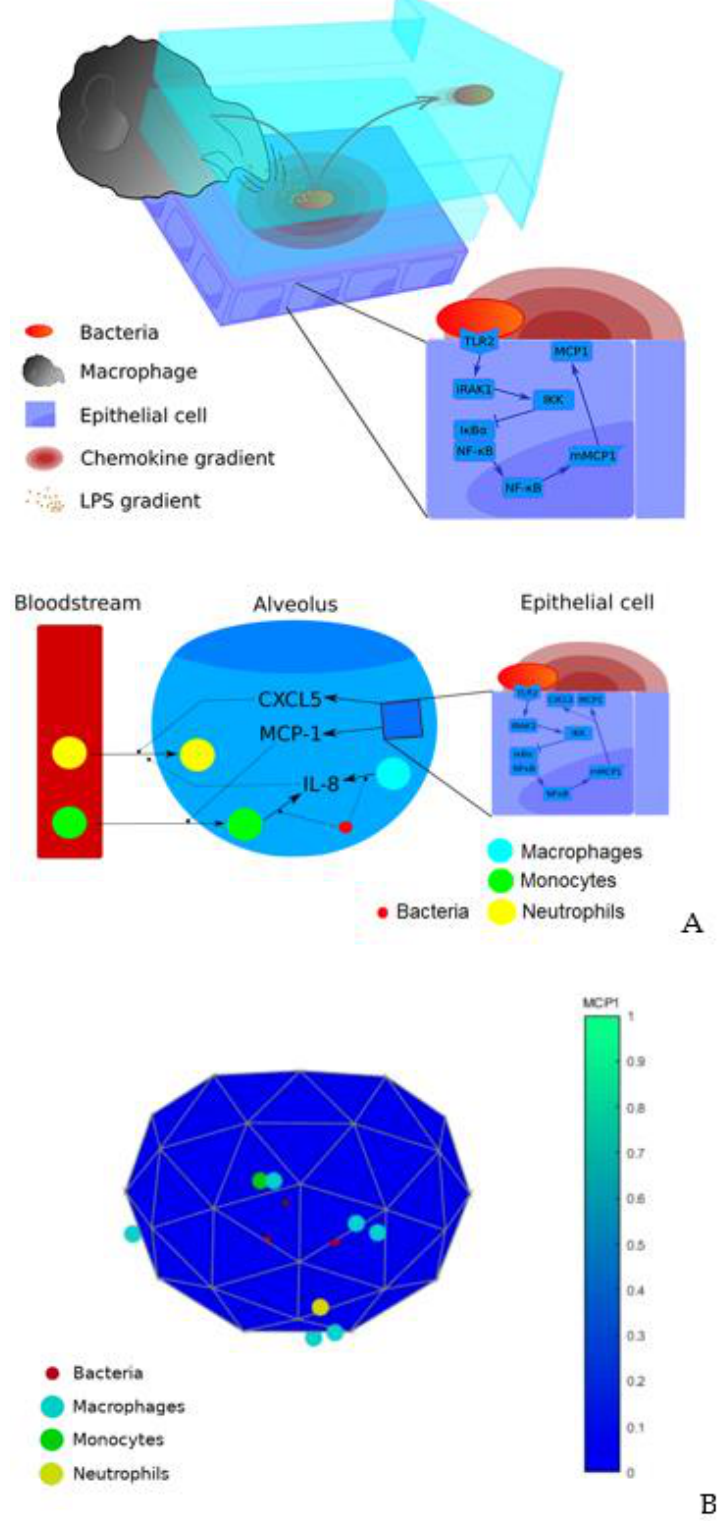
Figure 4. ( A ) Diagram of previous model. ( B ) Frame of the simulation of the extended model. The color bar represents the average concentration of the chemokine MCP1 between all epithelial cells and normalized to a sufficient high value to make it visible during the whole simulation (2.4·10 −3 ng/mL).